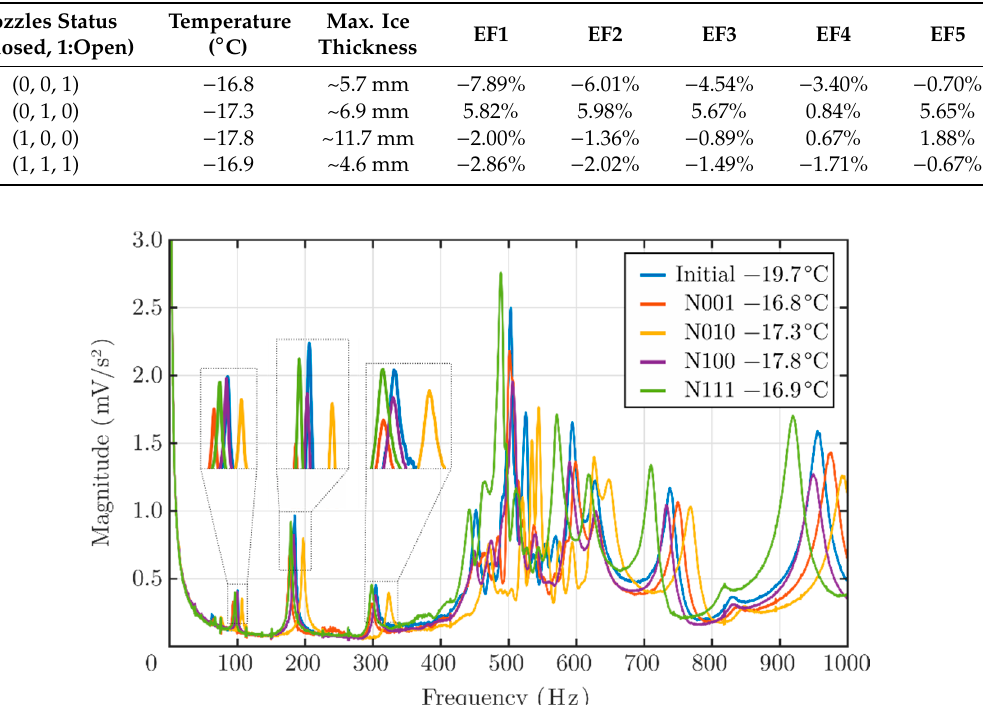
Figure 7. Response spectra of measurements conducted with different nozzle setups.